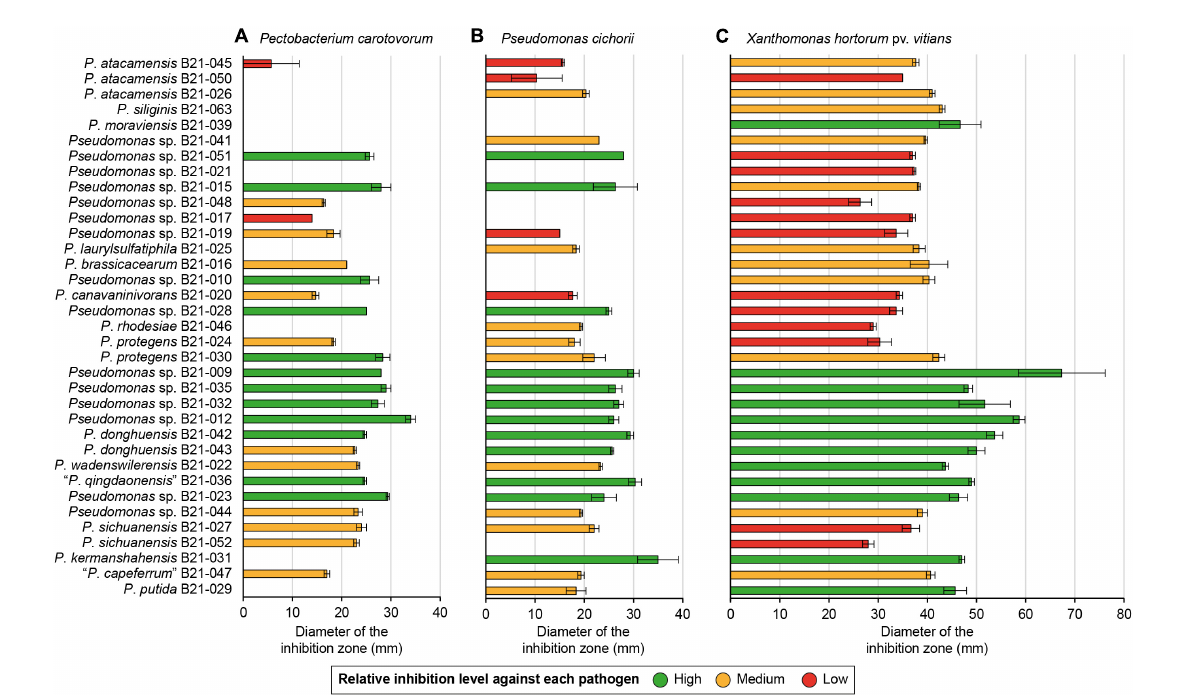
FIGURE1 In vitro inhibition abilities of 35 Pseudomonas strains inhibiting P . carotovorum (A) , P . cichorii (B) , and/or X . hortorum pv. vitians (C) . The colored inhibition levels against a given pathogen are significantly distinct from each other regarding the “High” and “Low” group ( p < 0.001, Fisher’s least significant difference procedure). The “Medium” group strains do not necessarily display any significant difference in terms of inhibitory activity with strains from the other two groups. Strains are sorted according to their phylogenetic relationships. Error bars: standard